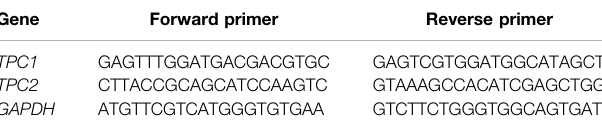
TABLE 1 | Primer sequences 5 ′ -3 ′ . Gene Forward